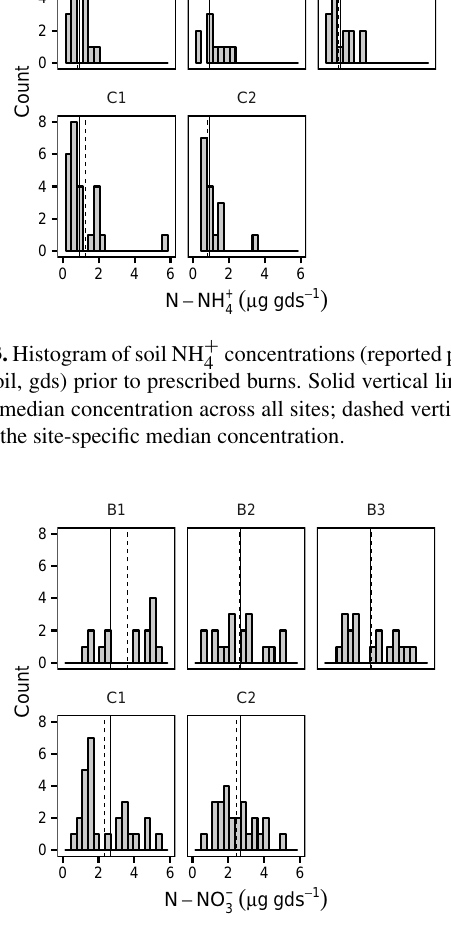
Figure 4. Histogram of soil NO − concentrations (reported per gram 3 of dry soil, gds) prior to prescribed burns. Solid vertical lines indi- cate the median concentration across all sites; dashed vertical lines indicate the site-specific median